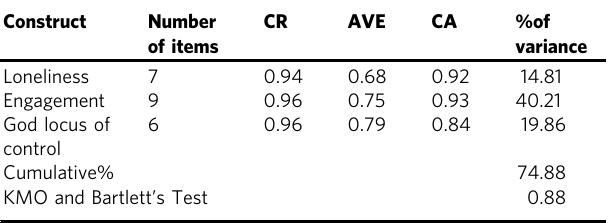
Table 2 Reliability and validity of the study variables.